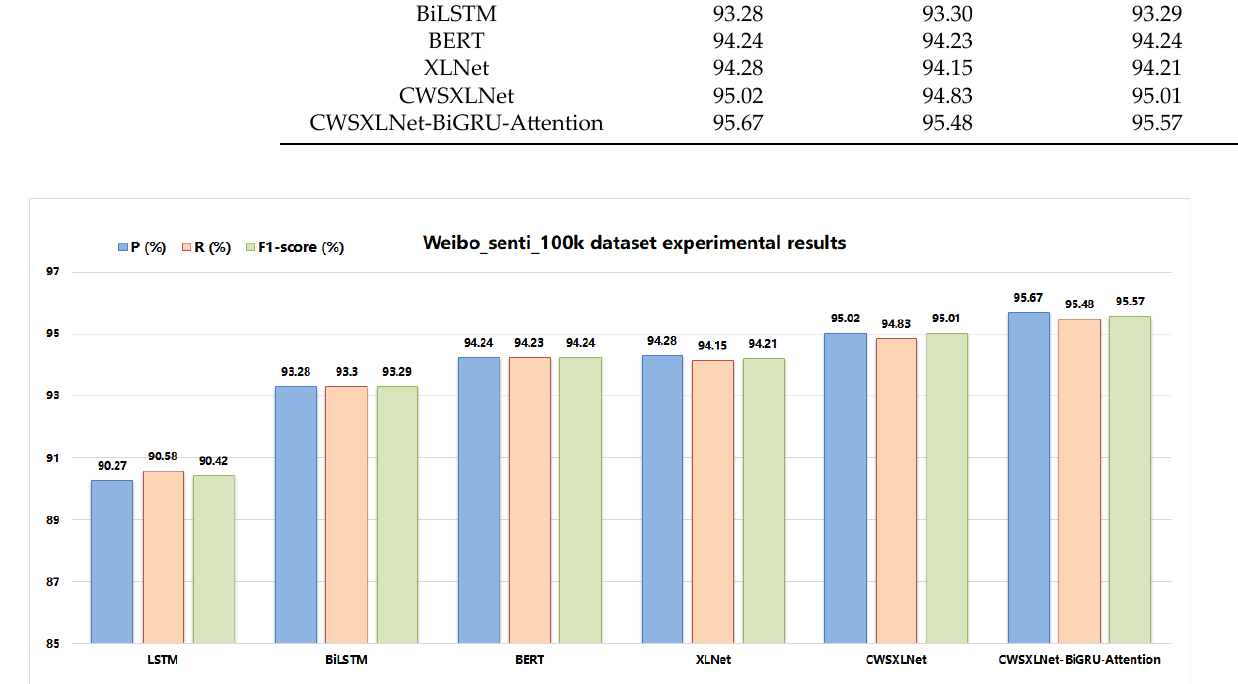
Figure 14. Weibo_senti_100k dataset experimental results.